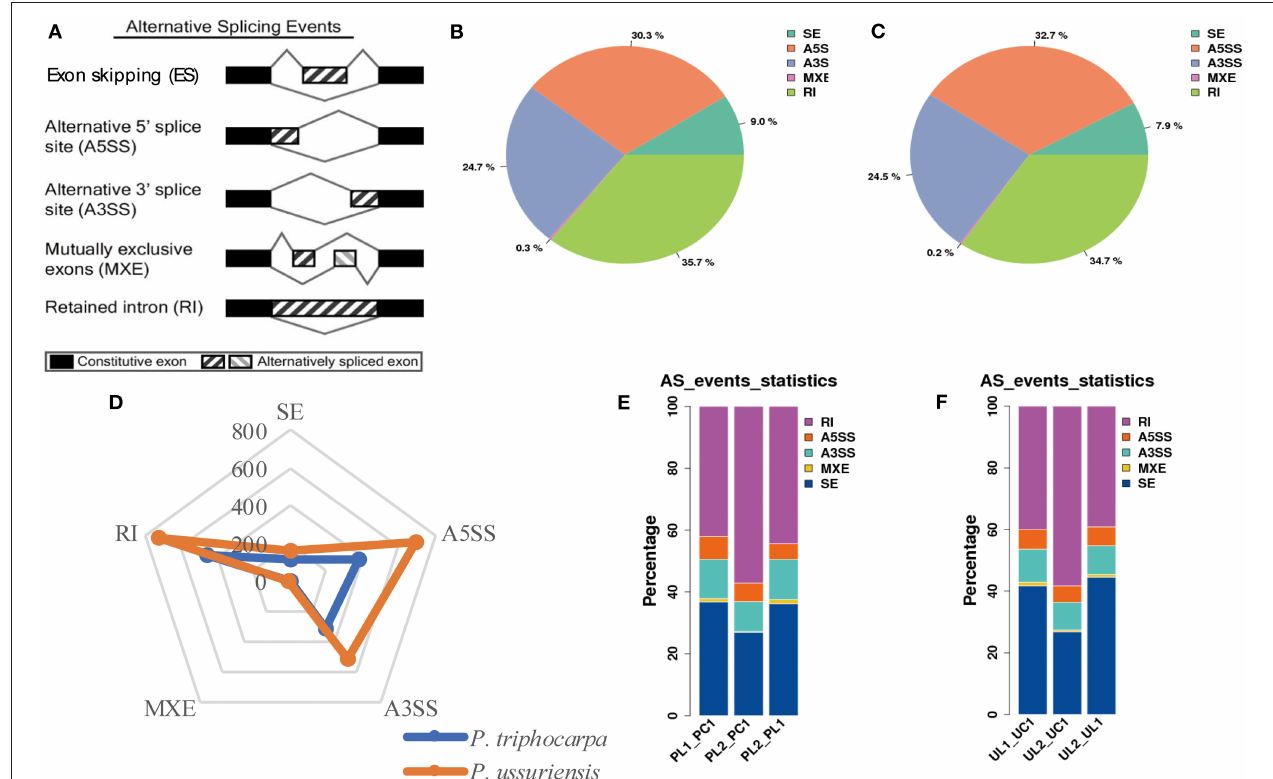
FIGURE 4 | Comparison of alternative splicing (AS) events in response to cold stress in P. trichocarpa and P. ussuriensis identified by PacBio sequencing. (A) AS types. (B) The proportion of different AS types in response to cold stress in P. trichocarpa. (C) The proportion of different AS types in response to cold stress in P. ussuriensis. (D) A radar plot showing the percentage of AS types in response to cold stress in P. trichocarpa and P. ussuriensis . (E) Comparison of the AS types at different cold temperatures in P. trichocarpa . PL1_PC1: AS percentage statistical analysis at 3 ◦ C compared with 25 ◦ C in P. trichocarpa ; PL2_PC1: AS percentage statistical analysis at − 3 ◦ C compared with 25 ◦ C in P. trichocarpa ; PL2_PL1: AS percentage statistical analysis at − 3 ◦ C compared with 3 ◦ C in P. trichocarpa. (F) Comparison of the AS types at different cold temperatures in P. ussuriensis . UL1_UC1: AS percentage statistical analysis at 3 ◦ C compared with 25 ◦ C in P. ussuriensis ; UL2_UC1: AS percentage statistical analysis at − 3 ◦ C compared with 25 ◦ C in P. ussuriensis ; UL2_UL1: AS percentage statistical analysis at − 3 ◦ C compared with 3 ◦ C in P. ussuriensis